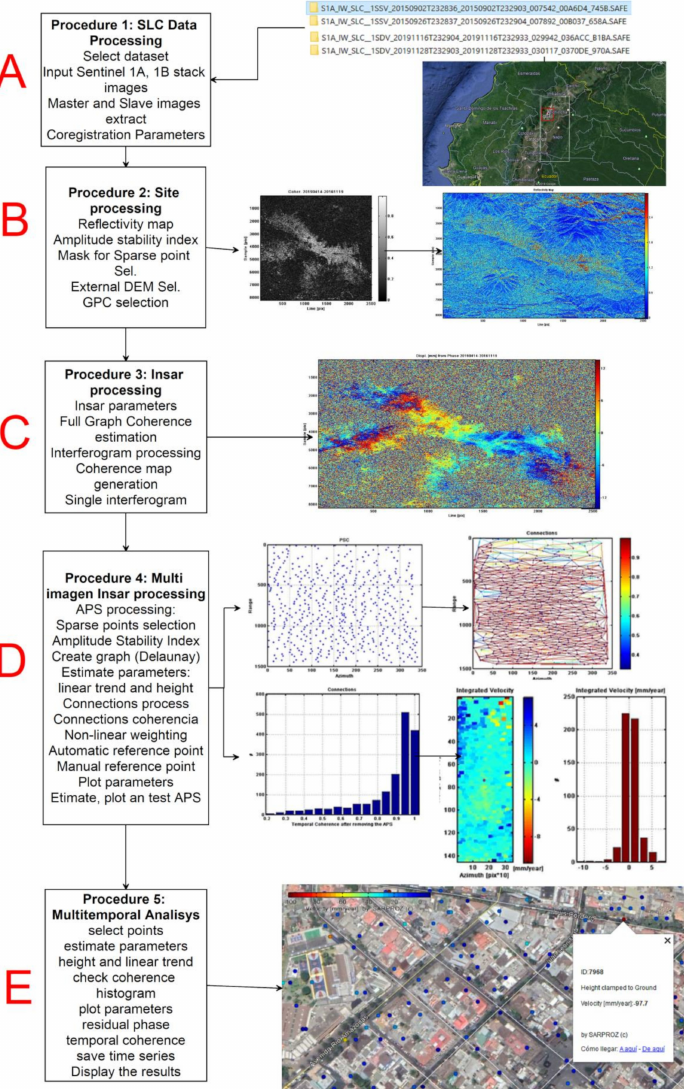
Figure 3. The SARPROZ software procedures used to obtain ground deformations by atmospheric phase screen (APS) estimation & multitemporal analysis. Description for ( A–E ) is given inside the figure. Procedure 2: Site processing (B). Preliminary anlalysis. Reflectivity map: with this function the software generates the reflectivity map as the temporal average of all images of the dataset that have been chosen to process. Amplitude stability index: is a single number which gives a statistical property of the amplitude series. Mask for sparse point selection: a threshold of the amplitude stability index value will be inputted, with values greater than the threshold to be selected and the remaining will be masked. Figure 4B. External DEM selection: used to remove the topographic phase and geocoding images. Ground control point (GPC) selection: used to orbital correction, geocoding, nterferogram flattening, persistent scatterers. Full graph coherence: used to estimates the coherence of all possible connections (interferograms) in the images